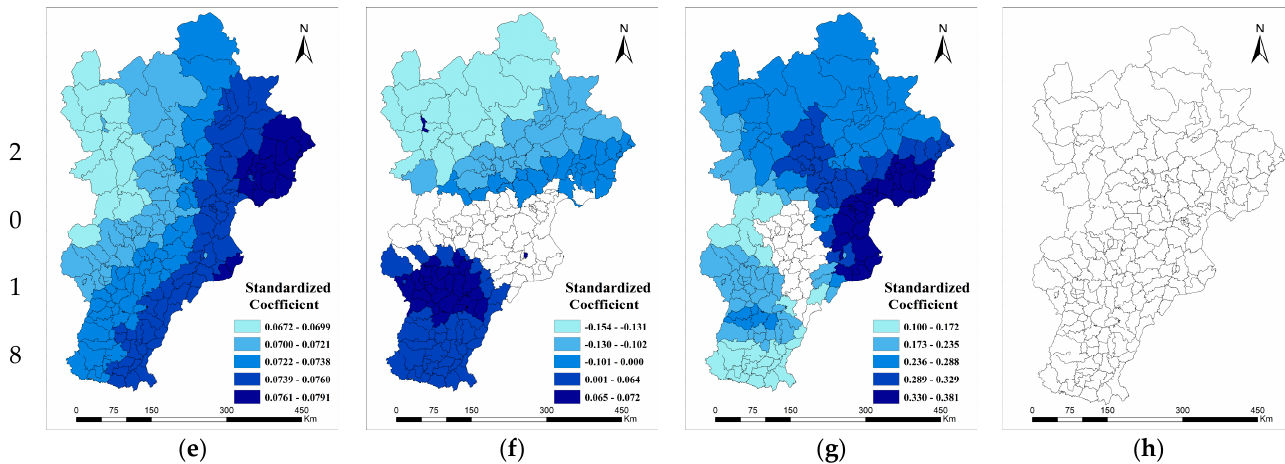
Figure 6. Spatial heterogeneity of the influence of ecological factors on carbon storage. The first and second rows represent the results for 2010 and 2018, respectively. ( a , e ): PM 2.5 ; ( b , f ): Tempreture; ( c , g ): NDVI; ( d , h ): RH. Please see Table S1 for an explanation of each abbreviation in this figure.